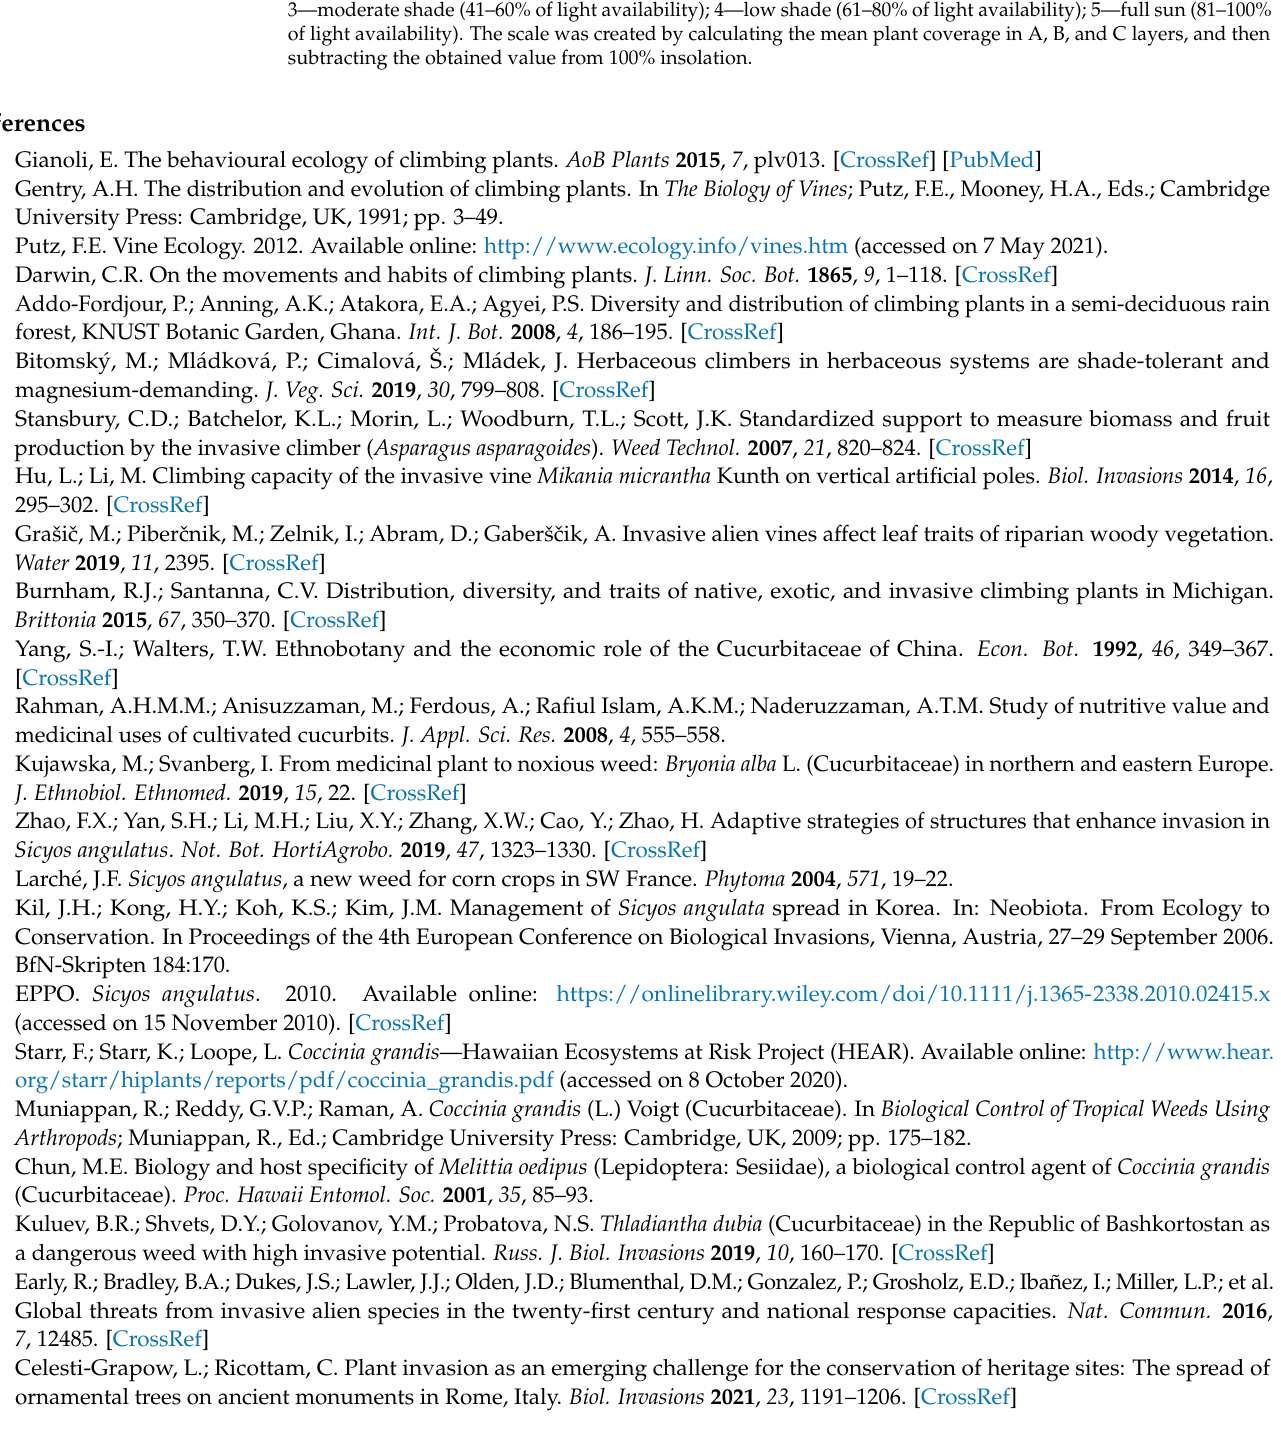
3—moderate shade (41–60% of light availability); 4—low shade (61–80% of light availability); 5—full sun (81–100% of light availability). The scale was created by calculating the mean plant coverage in A, B, and C layers, and then subtracting the obtained value from 100%